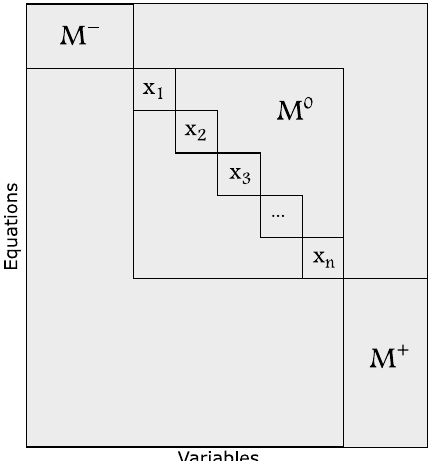
Figure 4. Canonical decomposition of the structure graph M